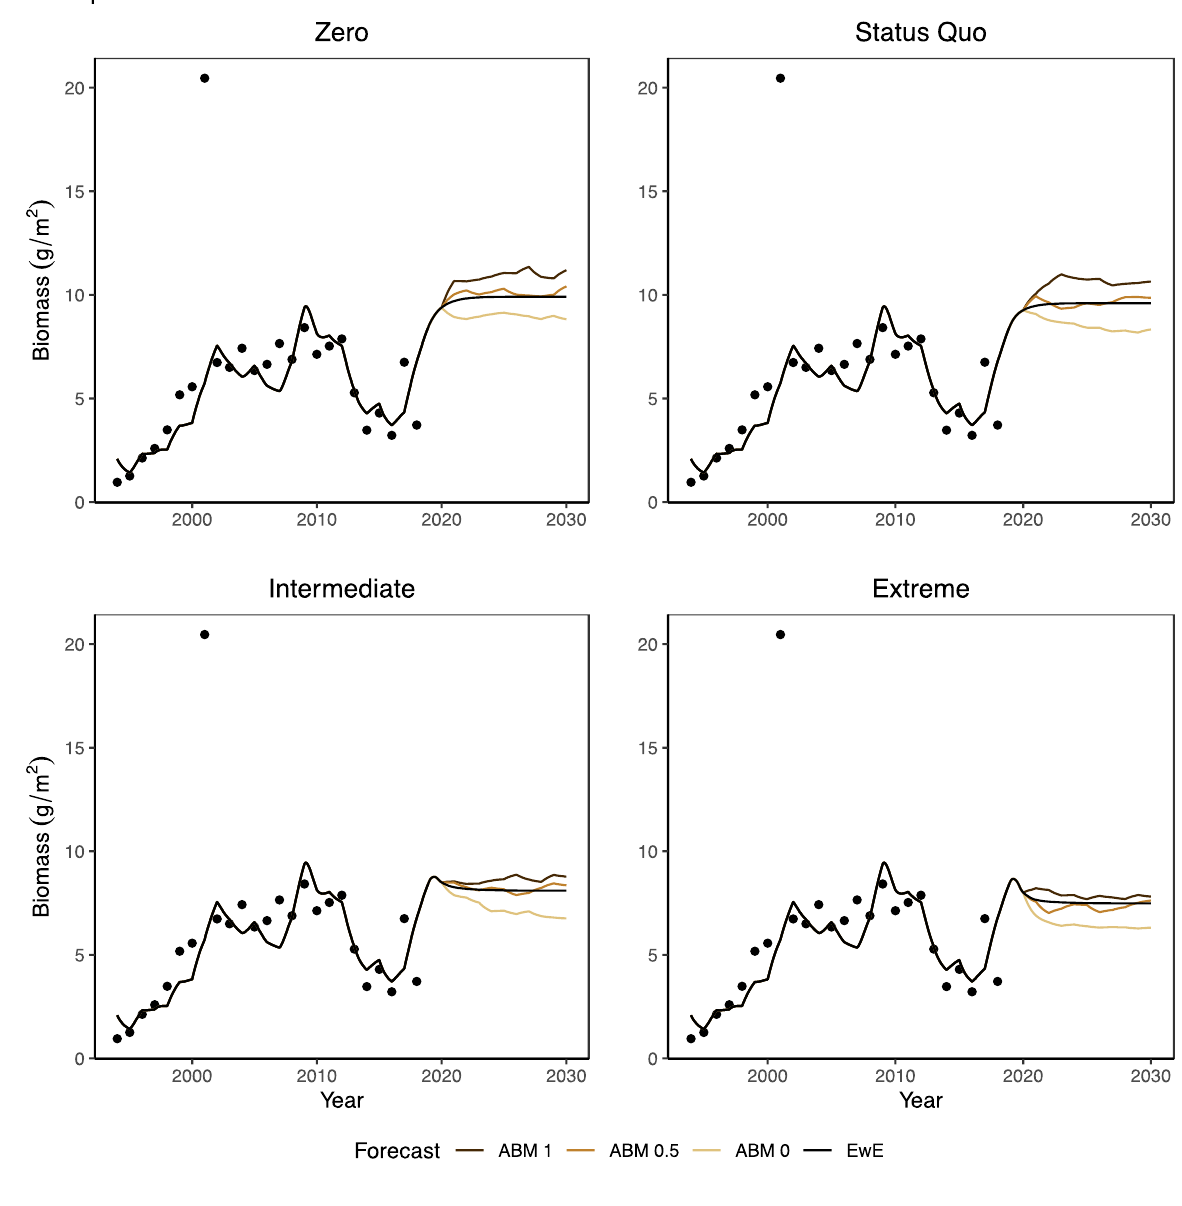
Fig. A1.2. Piscivorous fish biomass forecasts of the coupled social-ecological model for the four scenarios of commercial forage fish harvest compared to the EwE forecast. The three different color lines are the variations of satisfaction loss rate in the social-ecological model, and the black line represents the stand-alone food web